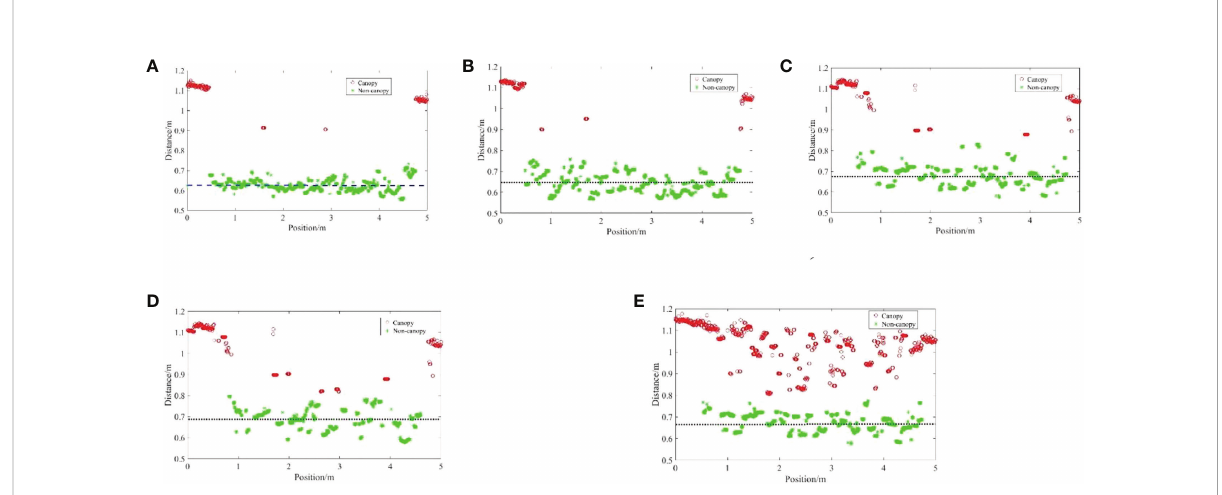
FIGURE 20 Detection distance relative error of ultrasonic sensor on fi eld ground. The K-means clustering algorithm is used to cluster the data under fi ve density conditions, realizing the segmentation of canopy and non canopy detection data. (A) Distance detected by the ultrasonic sensor to the 100% wheat canopy; (B) Distance detected by the ultrasonic sensor to the 75.56% wheat canopy; (C) Distance detected by the ultrasonic sensor to the 47.35% wheat canopy; (D) Distance detected by the ultrasonic sensor to the 31.05% wheat canopy; (E) Distance detected by the ultrasonic sensor to the 19.89% wheat